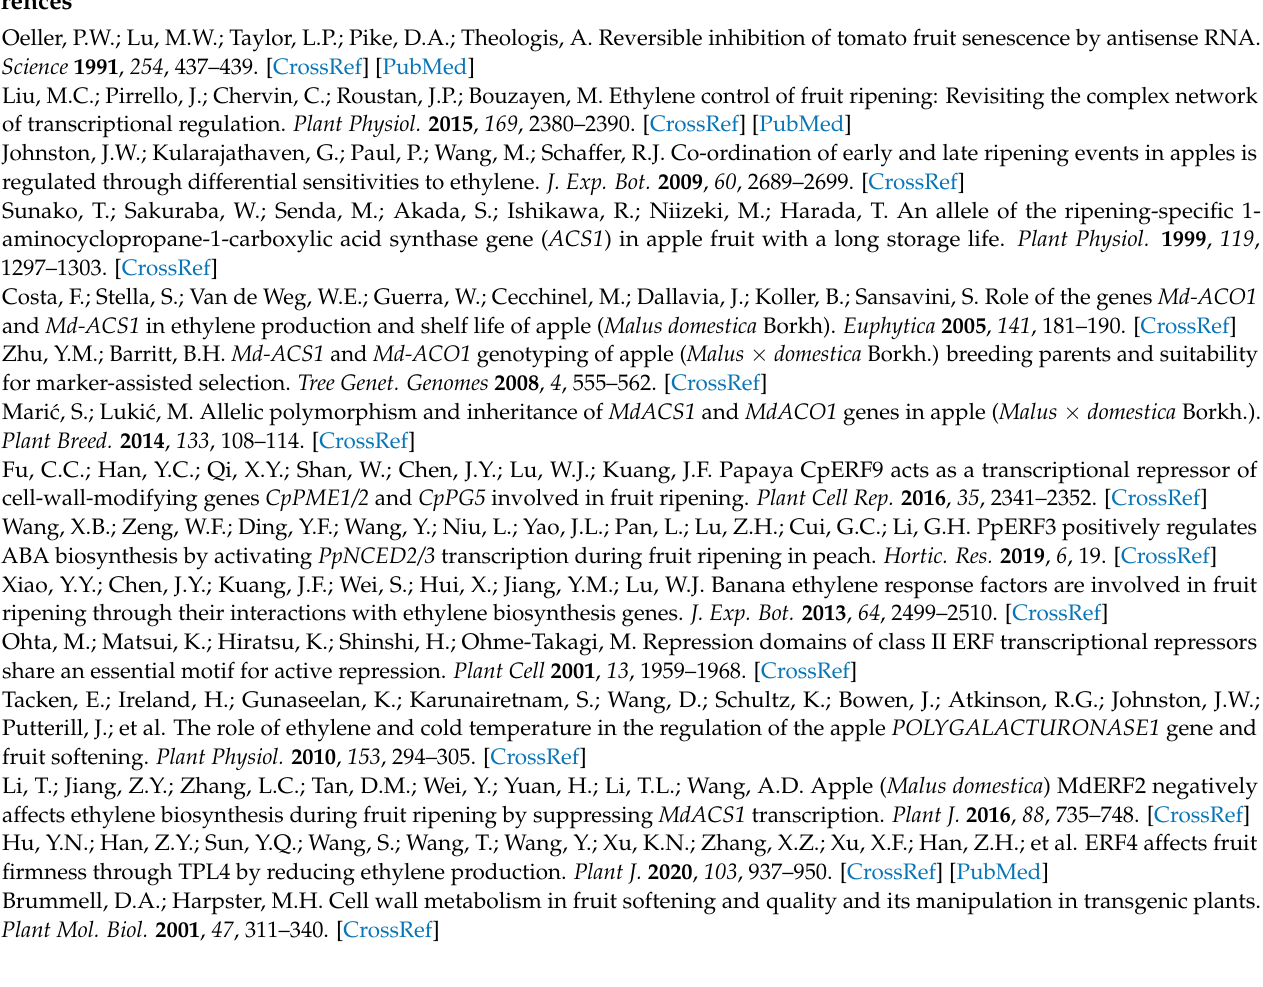
Figure S4. Sequence alignments of lncRNA PG1 homologs. LncRNA PG1 homolog sequences were identified from on chromosome 0, 1, 5, 11 and 10 by Blast search, PCR-amplified from genomic DNA of “Huashuo”, cloned, sequenced, and aligned using Geneious software v9.1.4; Figure S5. Six highly similar sequences of lncRNA were annotated as putative nonprotein-coding genes. According to the apple lncRNA database information, six highly similar sequences of lncRNA were annotated as putative nonprotein-coding genes. PLnc DB (https://www.tobaccodb.org/plncdb/, accessed on 1 March 2023); Table S1. Information of the four apples; Table S2. Scan two alleles of MdPG1 for differential TF binding; Table S3. LncRNA PG1 homologs identified in apple genome; Table S4. Genotyping of lncRNA PG1 homologs in eight apple cultivars; Table S5. The list of primer sequences used in this study; Table S6. Accession numbers of proteins to generate the phylogenetic